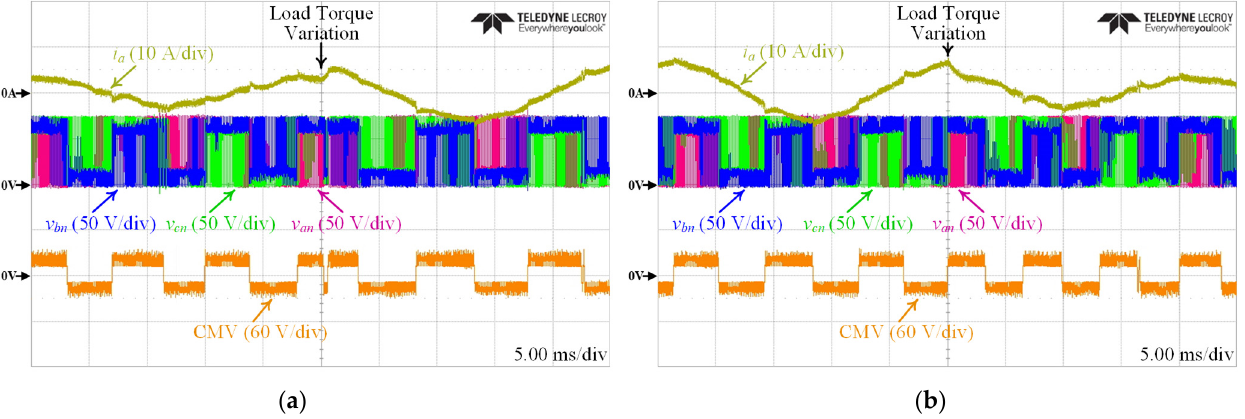
Figure 23. Experimental results of three-phase current at rated load current: ( a ) At rotor speed of 1000 rpm; ( b ) At rotor speed of 1500 rpm.